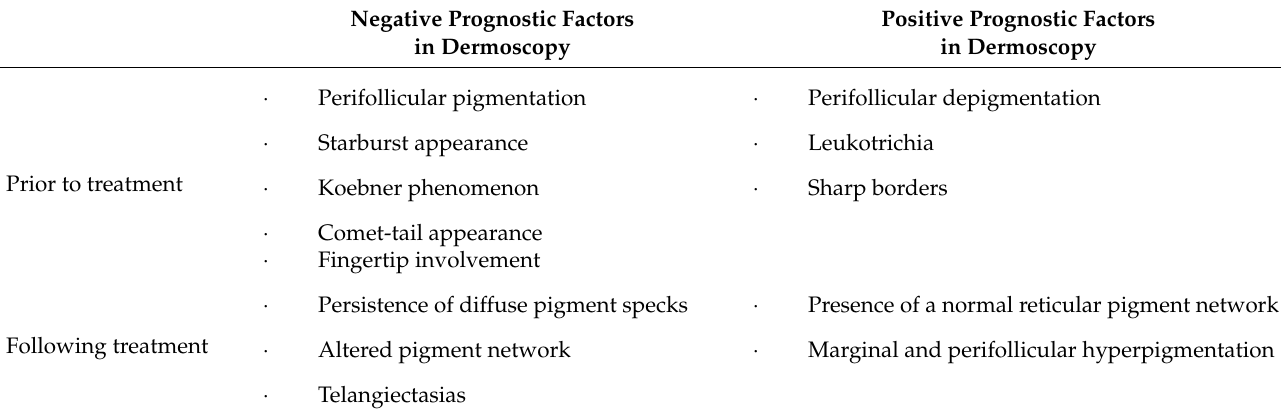
Table 3. Evaluation of